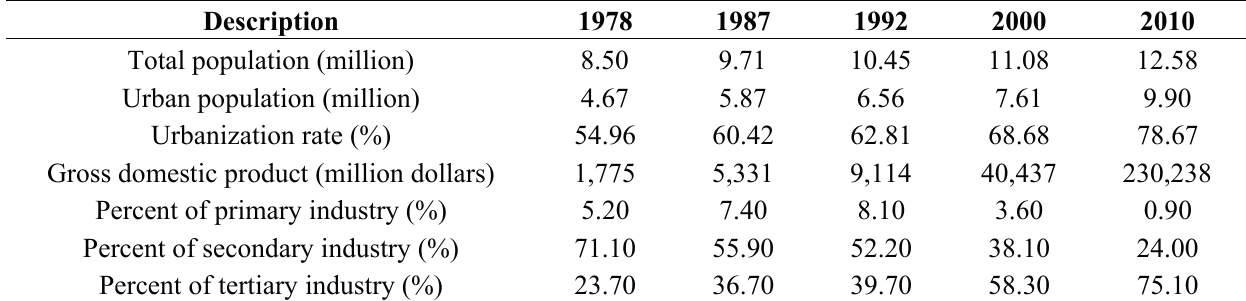
Table 2. 1978–2010 main social and economic statistics for Beijing,